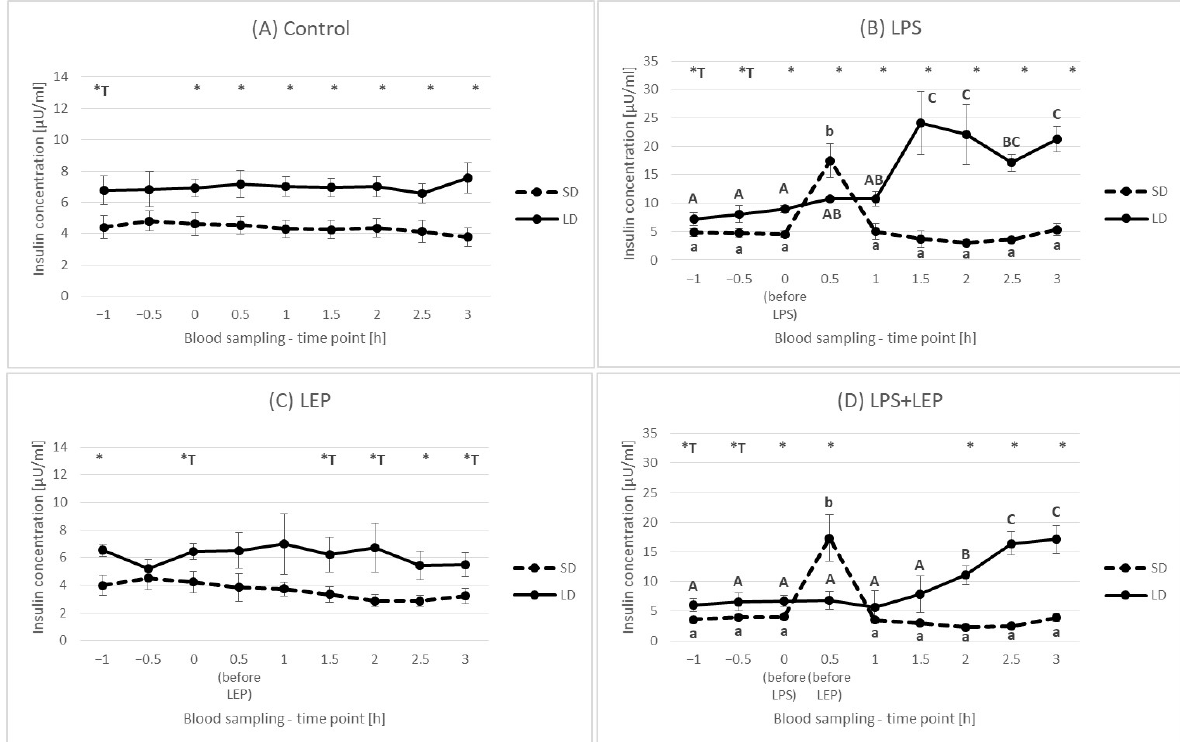
Figure 8. Plasma insulin concentration for each experimental group separately (Control ( A ), LPS ( B ), LEP ( C ) and LPS + LEP ( D )) at each examined time point and season; *—indicates the statistically significant difference between the short-day (SD) and long-day (LD) photoperiods at each time point according to Student’s t -test ( p ≤ 0.05) ( n = 6); *T—indicates the tendency in a difference between photoperiods at each time point according to Student’s t -test (0.1 > p > 0.05); a–b and A–C— indicate the statistically significant difference between time points for the SD and LD seasons, re- spectively, according to a repeated measured analysis of variance (ANOVA) followed by Fisher’s post-hoc test ( p ≤ 0.05) ( n = 6). Groups: control—saline injection, LPS—lipopolysaccharide injection at a dose of 400 ng/kg of body mass after a 0 h time point, LEP—leptin injected at a dose of 20 μ g/kg of body mass at a 0.5 h time point, LPS + LEP—LPS and LEP injections at the same doses and time points as those in the LPS or LEP groups.